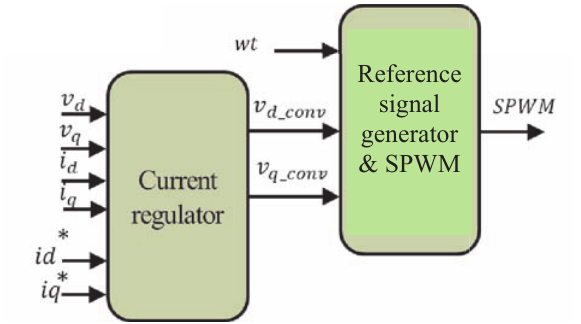
Fig. 4. Current regulator and SPWM.